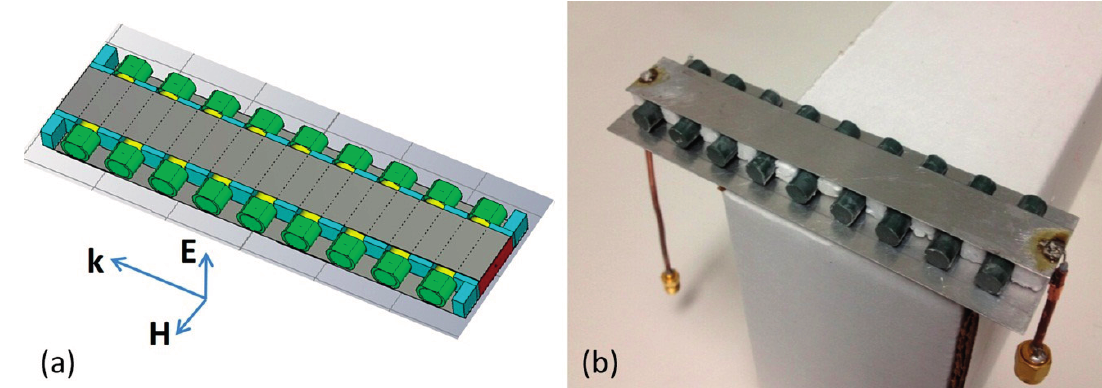
Figure 9. Transmission spectra of the waveguide with two inserted DRs filled by the media with the relative permittivities of 1.0; 1.01; 1.02; 1.03; 1.04 and 1.05, respectively. DR relative permittivity is 23.